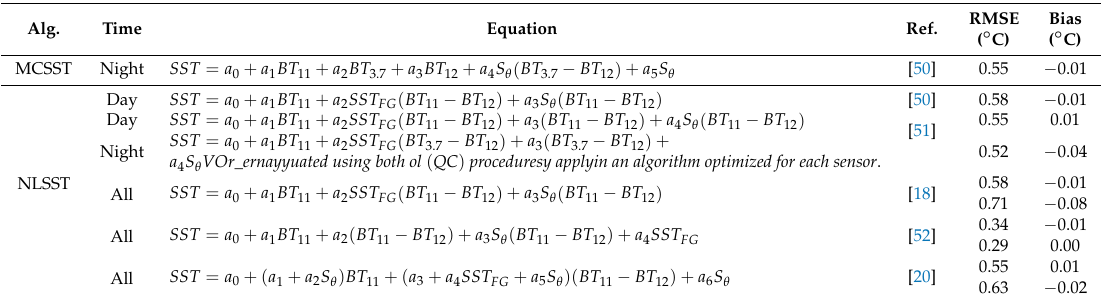
Table 3. Formula based on MCSST and NLSST algorithms ( BT 3.7 , BT 11 , and BT 12 : Brightness temperature at 3.7 µ m (SWIR), 11 µ m (IR1), and 12 µ m (IR2), SST FG : first-guess SST (in